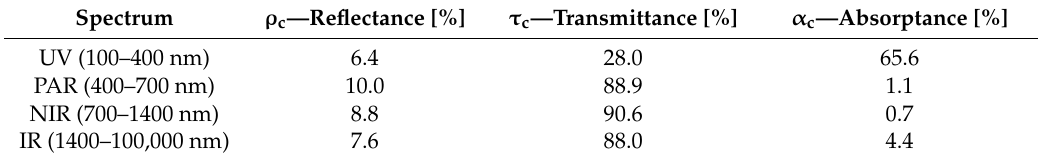
Table 3. Optical properties of polyethylene